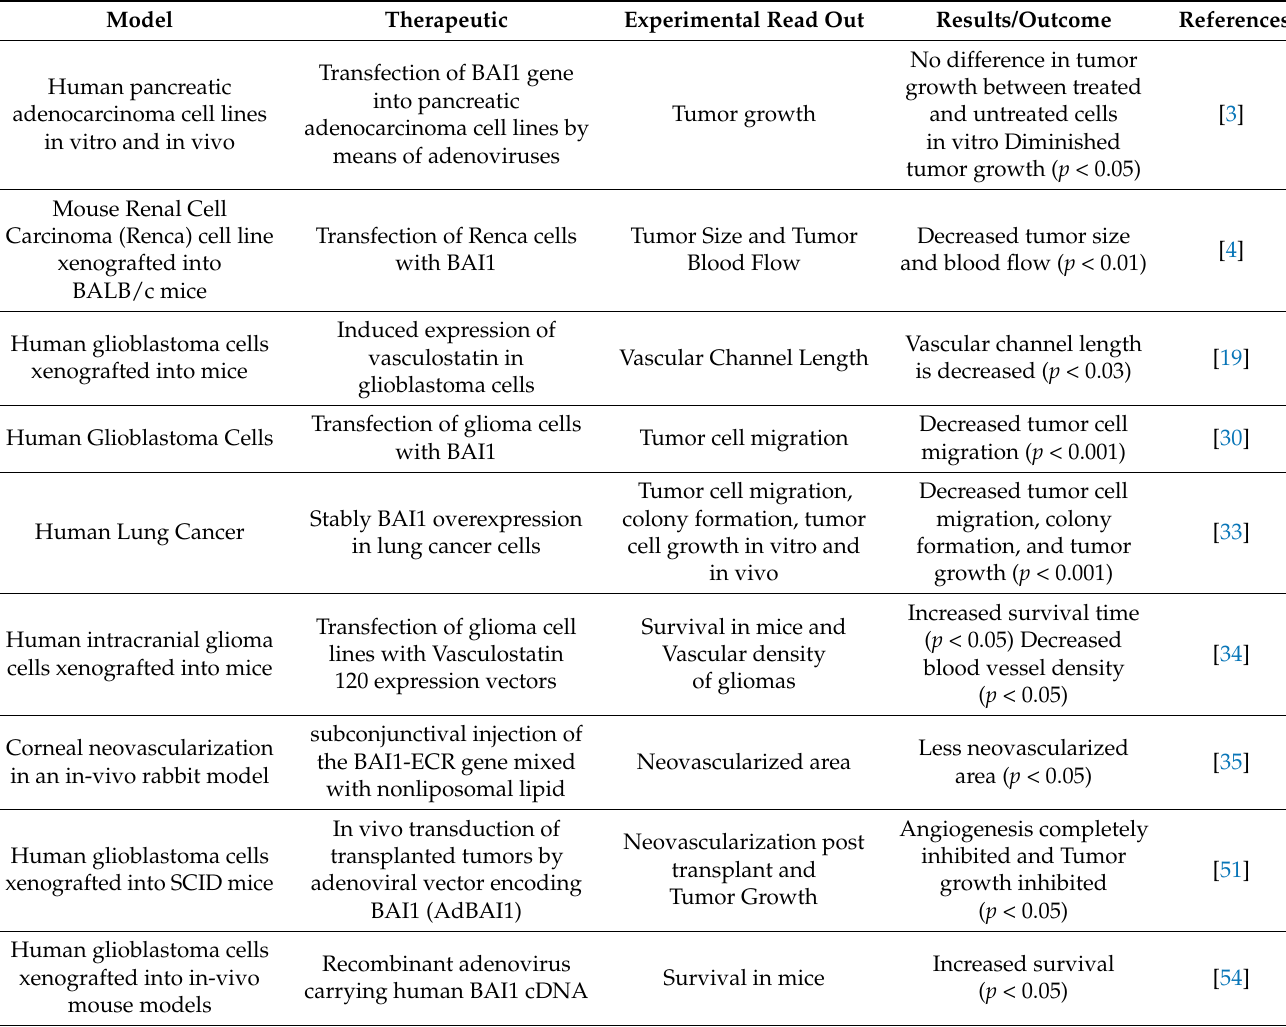
Table 2. The list of references shows the application and its therapeutic efficacy of BAI1. Model Therapeutic Experimental Read Out